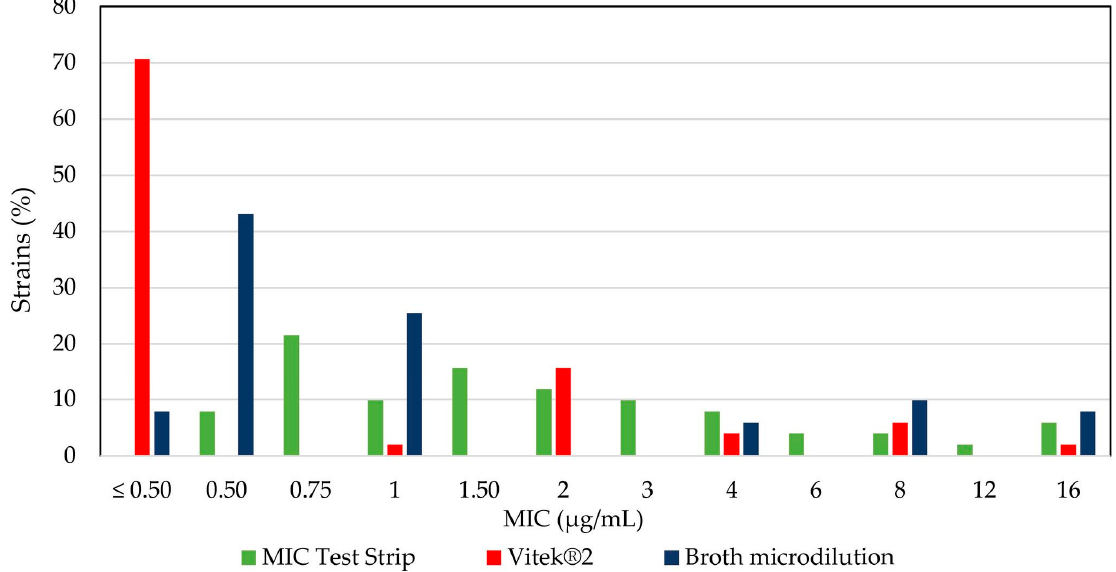
Figure 2. Percentage of A. baumannii strains susceptible to colistin at a given minimum inhibitory concentration (MIC), as determined by an MIC Test Strip, Vitek ® 2, and broth microdilution tests. The resistance breakpoint is ≥ 4 µ g/mL. Of note, all isolates that presented discordant MIC values between Vitek ® 2 and the microdilution test belonged to ICL II (not